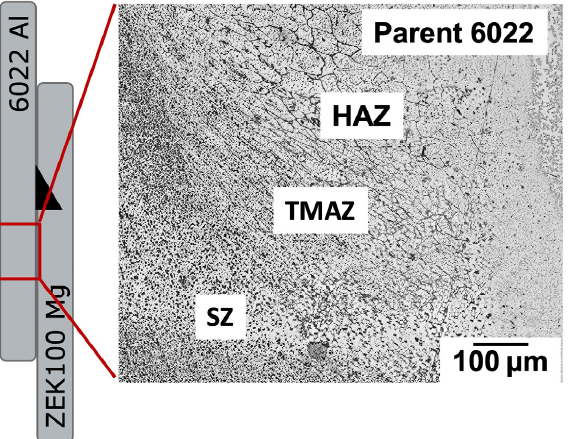
Figure 3. Optical microscopic pictures of etched 6022 Al from the top perspective: ( a ) Advancing side (AS) and ( b ) retreating side (RS).